Question: In one sentence, what is this figure communicating?
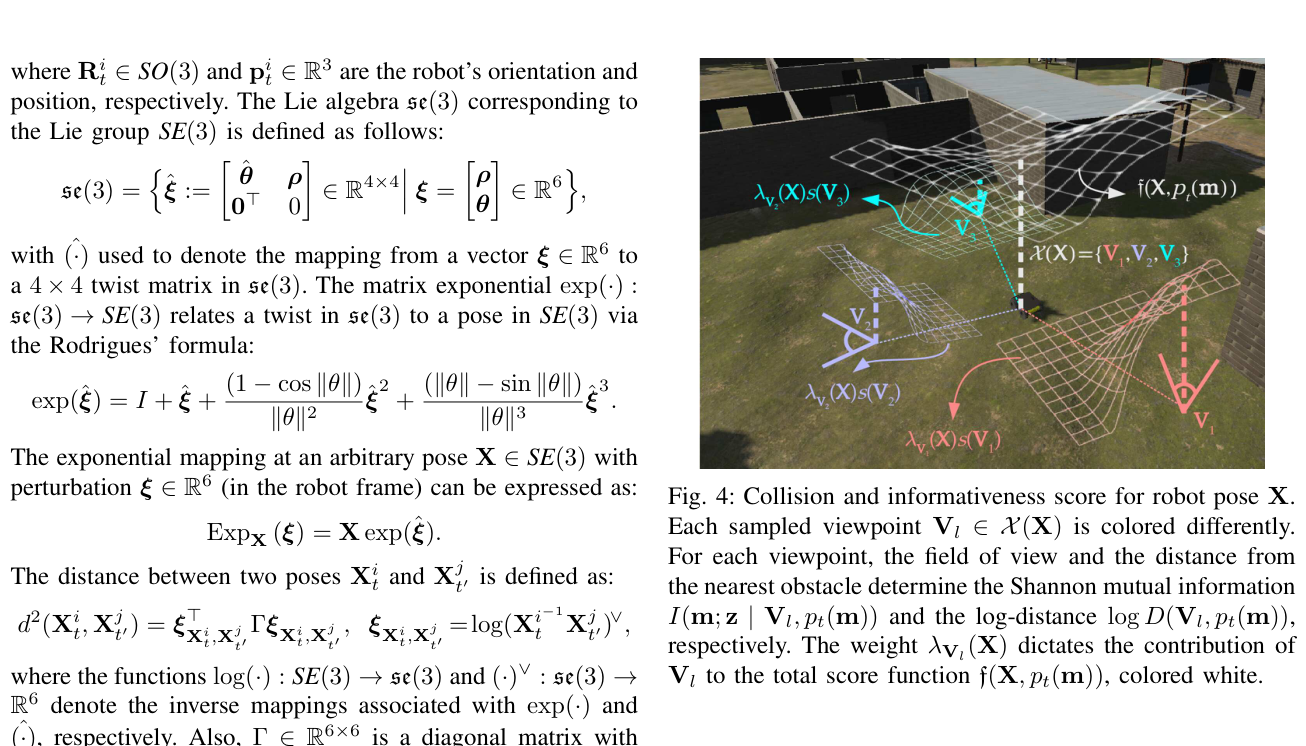
Answer: illustrates the collision and informativeness score f. Cooperative planning requires the robots to take into account the plans of their peers in order to avoid actions that provide redundant information. Let X = [X1 t+1:t+T , . . . , X|V| t+1:t+T ]⊤∈SE(3)|V|×T be the concate- nated T-length trajectories of all robots in V, where T is the planning horizon. In the remainder of this section, we use Xi,τ as an alternative notation for Xi t+τ, namely the SE(3) pose of robot i at time t+τ. The function q(Xi,τ, Xj,τ ′) quantifies the observation redundancy as the overlap between sensor field of views (FoVs) for two poses Xi,τ and Xj,τ ′: